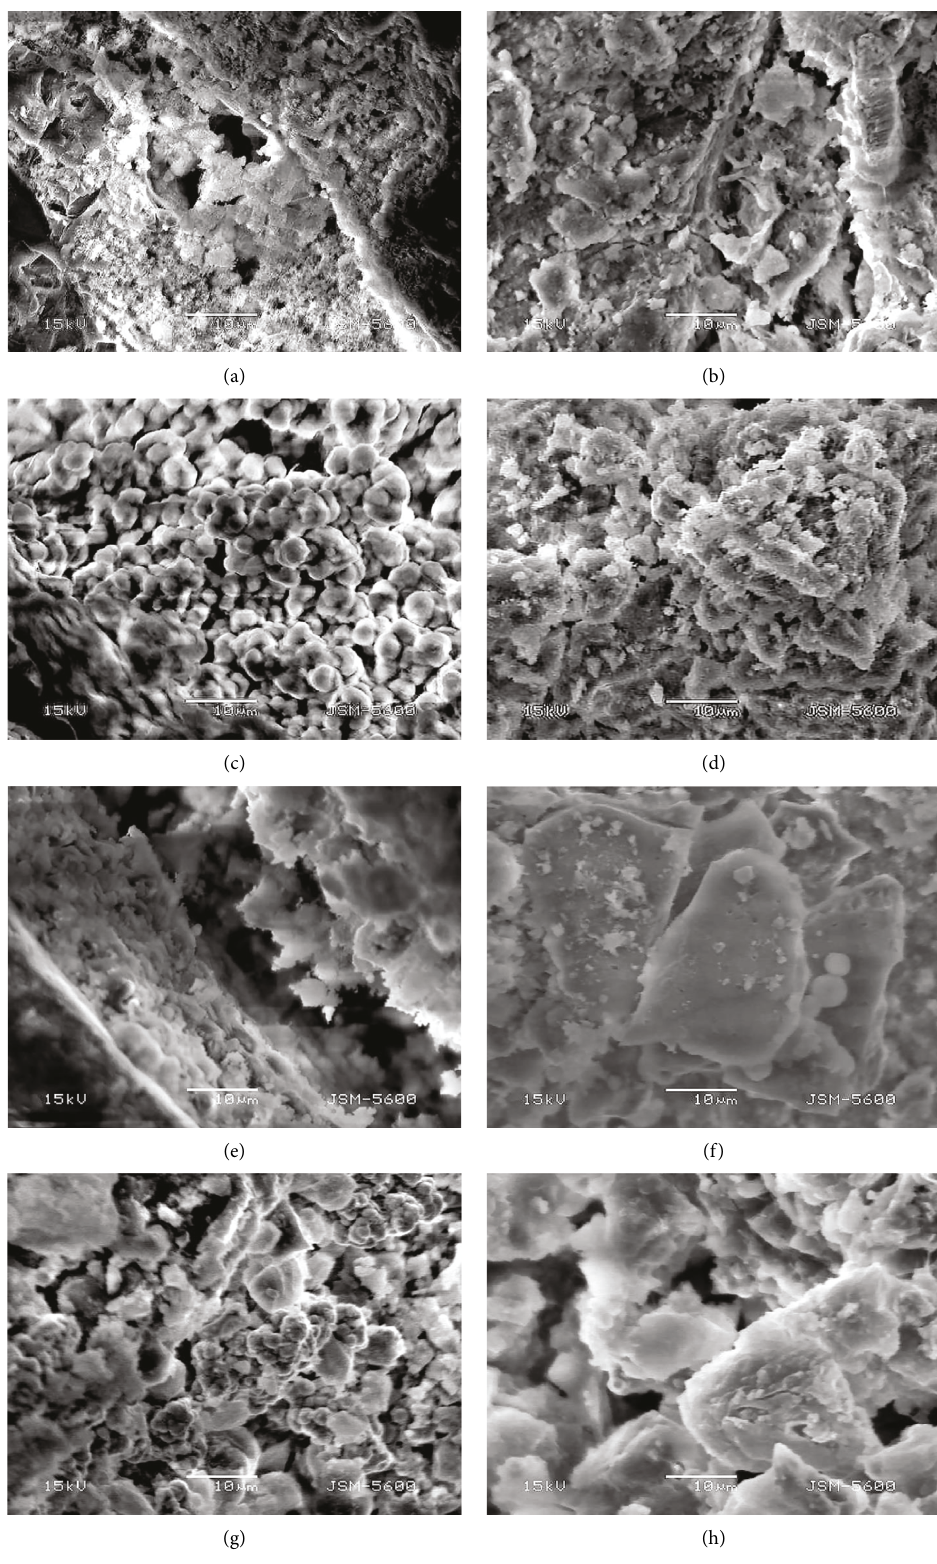
Figure 8: Scanning electron microscopic examination of the interfacial layer for MTA (A and B), ERRM (C and D), Biodentine (E and F), and BioMTA (G and H) (magnification